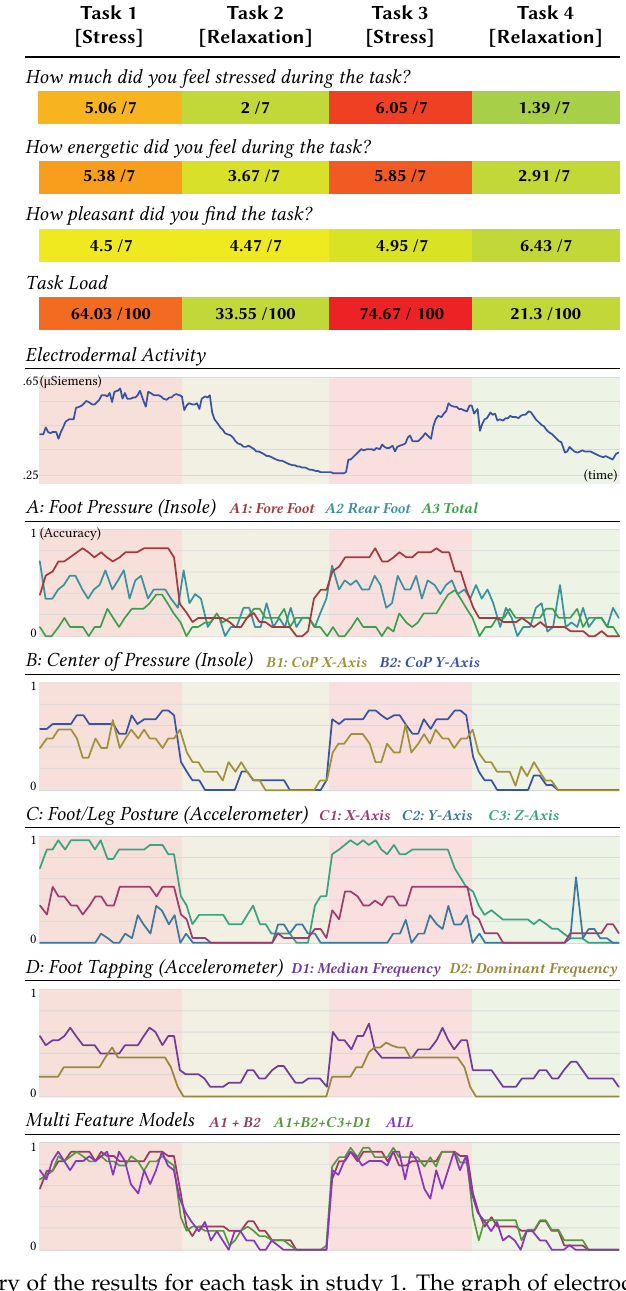
Figure 5. Summary of the results for each task in study 1. The graph of electrodermal activity was computed using the average of the mean electrodermal activity (EDA) over non-overlapping windows of 10 s of all the participants. Accuracy graphs were computed by calculating the average stress detection accuracy of all the participants over non-overlapping windows of 10